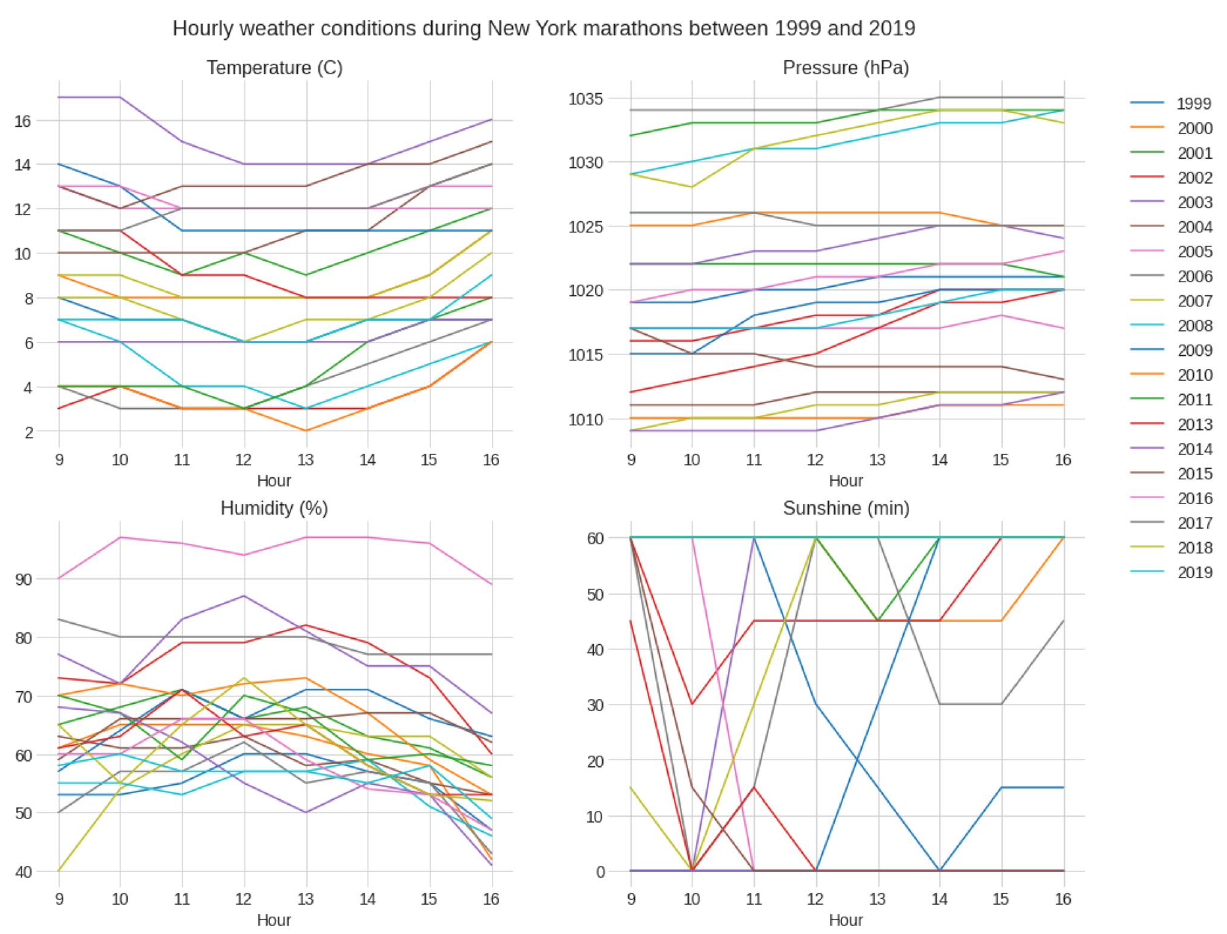
Figure 3. Hourly weather conditions during the ‘New York City Marathon’ between 1999 and